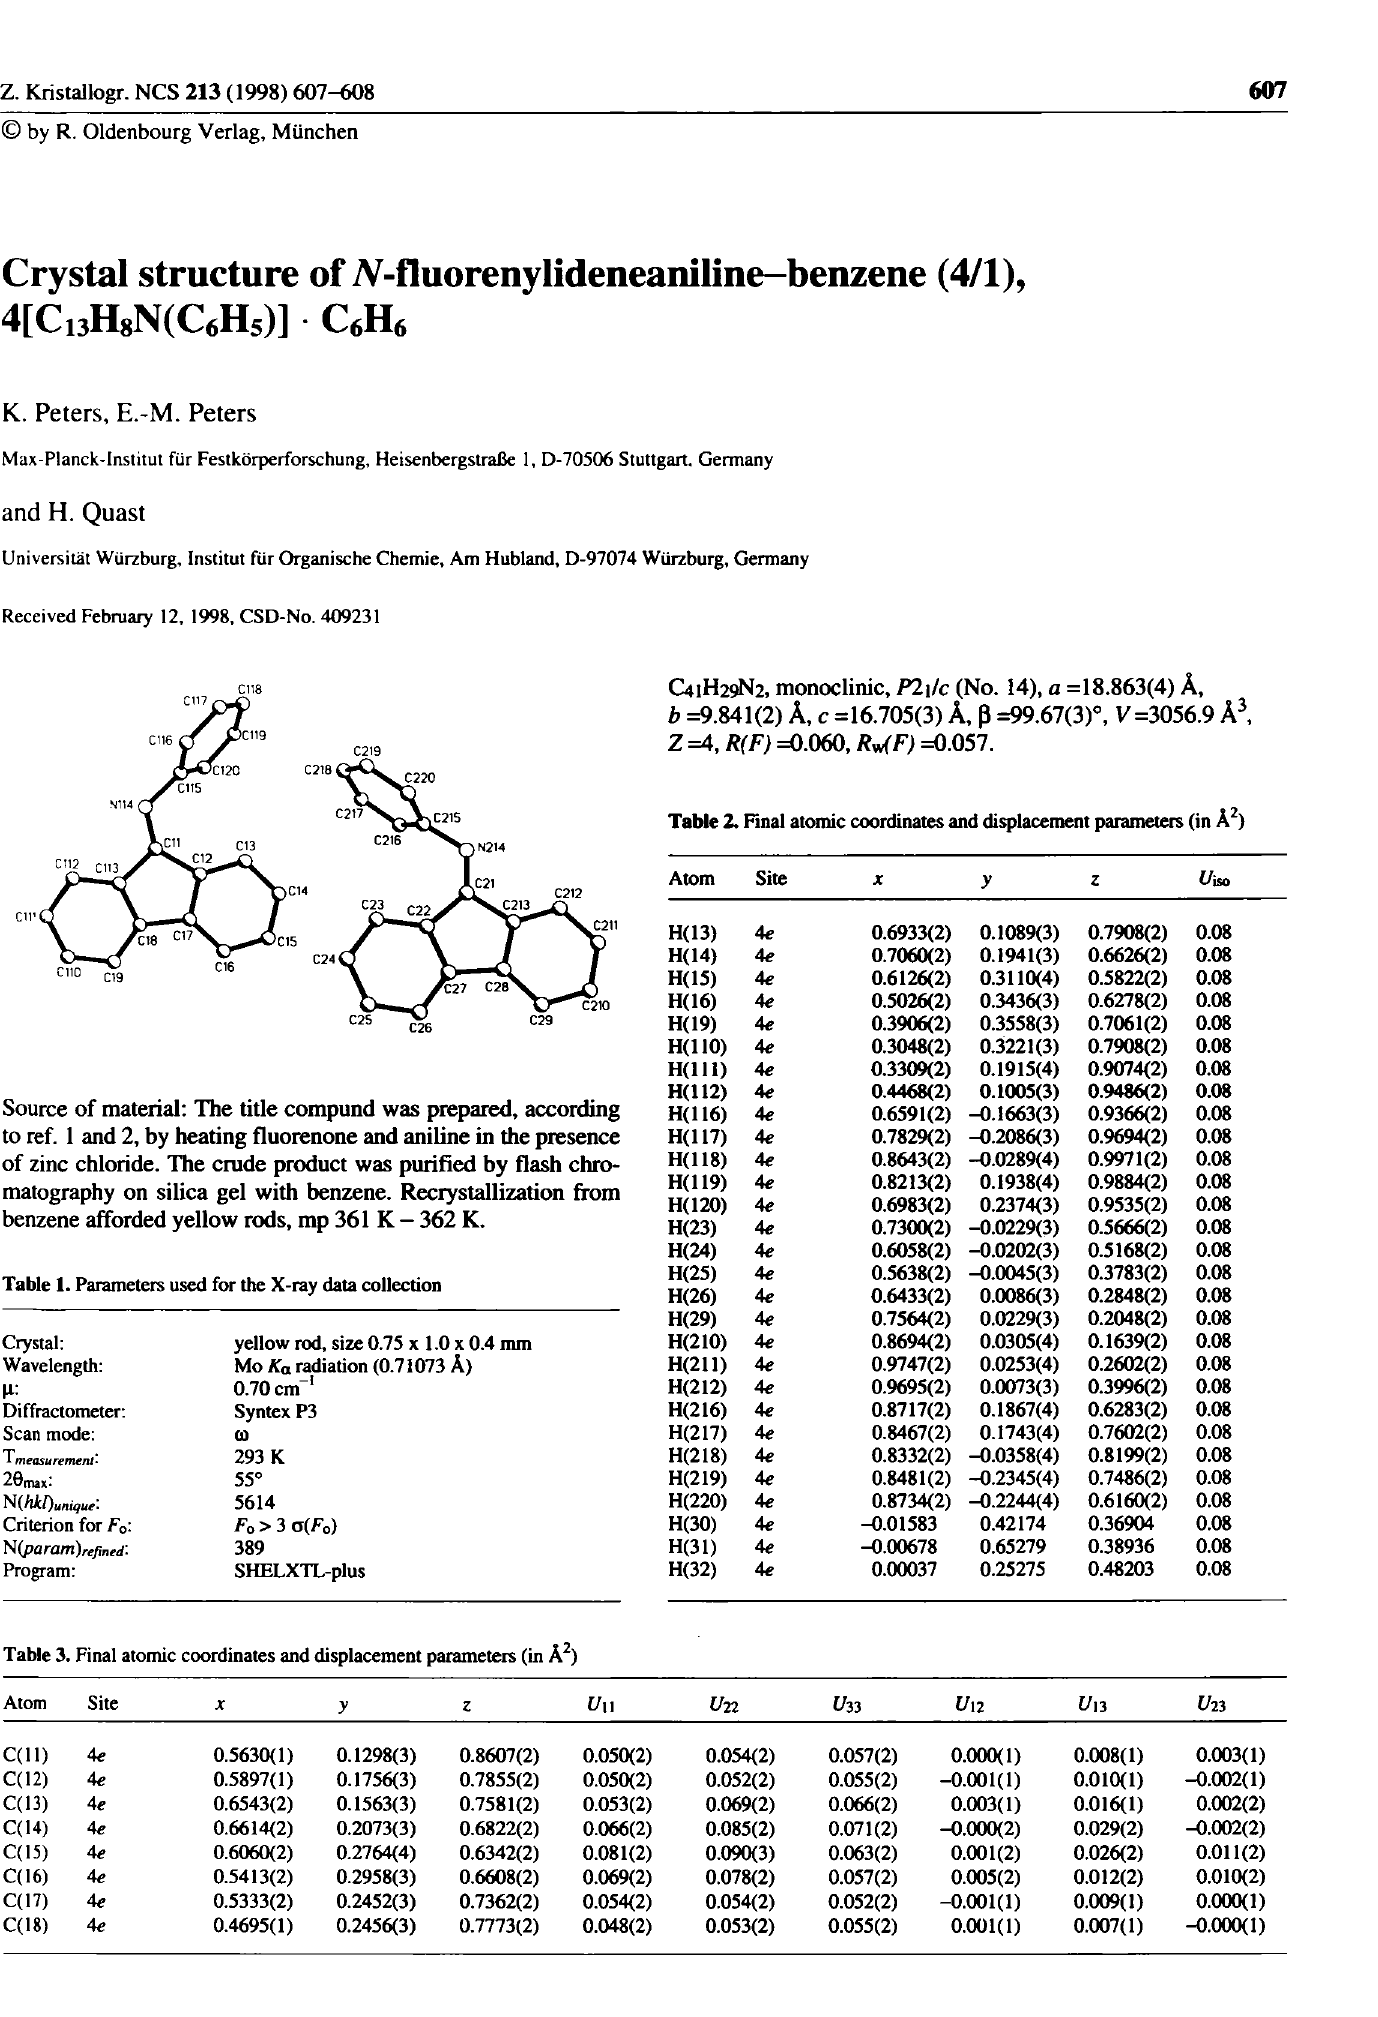
Table 3. Final atomic coordinates and displacement parameters (in